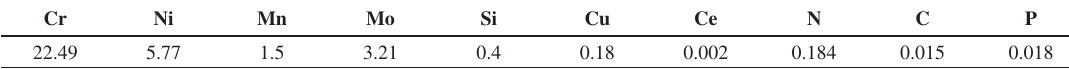
Table 1. Chemical composition of the UNS S32205 duplex stainless steel used in this work (balance Fe in wt.%). Cr